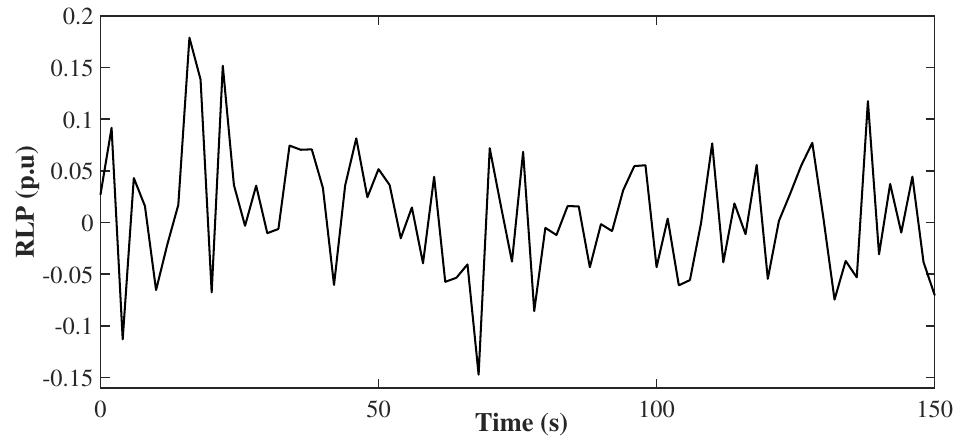
Figure 14. The loading/generation profiles for scenario 3.